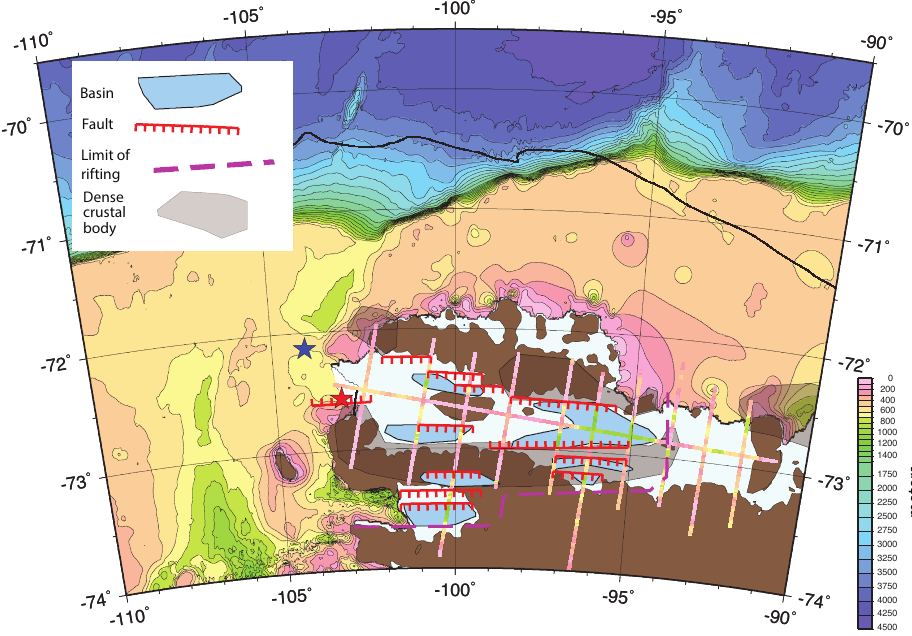
Fig. 4. Basins, faults and the spatial extent of rifting under Abbot and Cosgrove ice shelves, from inversion of Operation IceBridge gravity data along flight lines. Shaded areas show the extent of the high-density crustal bodies determined from the inversion. Gravity-derived bathymetry and radar-determined bed are shown along flight lines. Offshore marine bathymetry is from the International Bathymetric Chart of the Southern Oceans (IBCSO) (Arndt et al., 2013) contoured at 100m intervals to 1500 and 250m intervals for greater depths. Black lines along the western ice front between 72 ◦ 30.6 0 and 72 ◦ 42.4 0 S and across the outer shelf to the north of Abbot show the location of shipboard bathymetry lines discussed in the text. Stars show location of CTD stations nbp9402-0091 (red) and nbp0901-008 (blue) (Giulivi and Jacobs, 1997; Jacobs et al., 2011) shown in Fig.